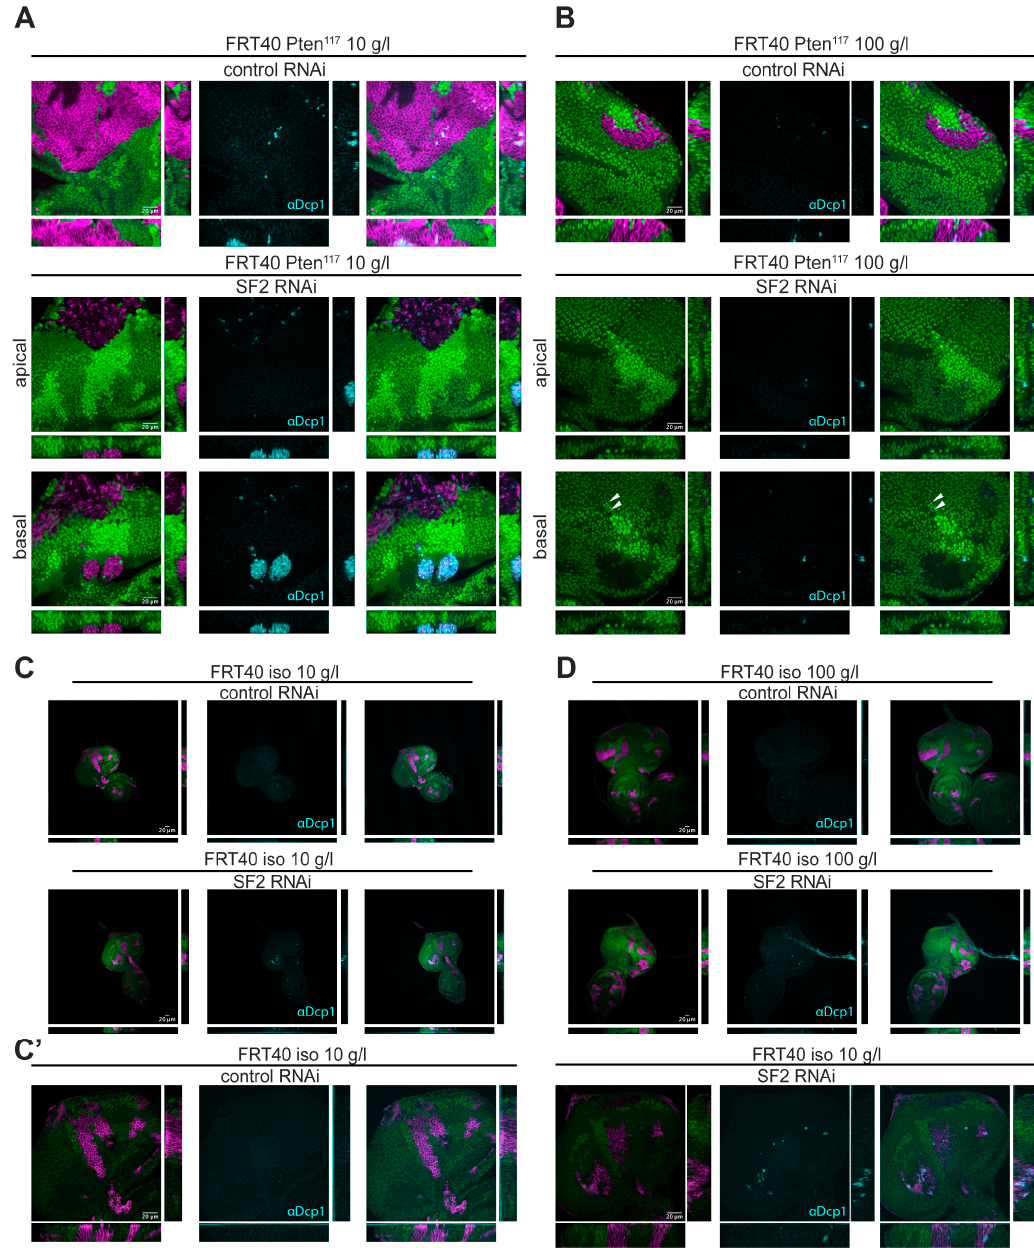
Figure 3. Massive apoptosis in Pten mutant cells with SF2 knockdown ( A ) SF2 knockdown in Pten 117 mutant cells (generated by the twin MARCM technique) results in massive apoptosis of the Pten mutant tissue as visualized by cleaved-Dcp1 staining upon NR (lower panel). The affected cells are located anterior to the morphogenetic furrow, induce apoptosis and are extruded from the epithelial layer. ( B ) SF2 knockdown eliminates Pten clones also under normal conditions. ( C , C ′ ) Control ( iso) clones are only mildly affected by SF2 knockdown, showing single apoptotic cells under NR. ( D ) Control (iso) clones are also mildly affected by SF2 knockdown under normal conditions. In all panels, clones are marked positively by RFP (magenta) and negatively by the absence of GFP (green). xz- and yz-cross-sections are shown below and on the right, respectively. Scale bars represent 20 μ m.